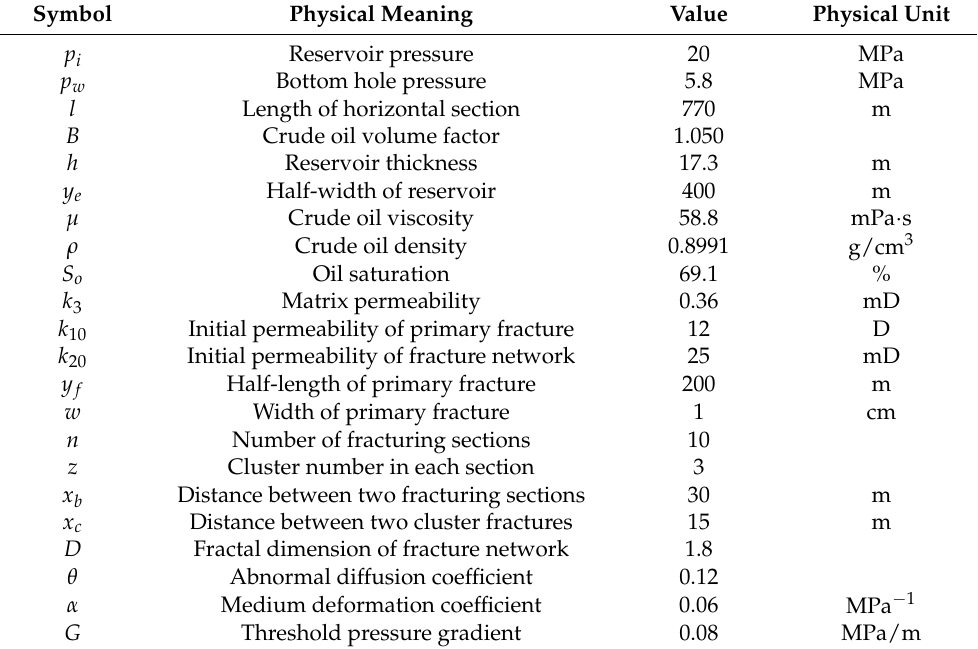
Table 2. Primary parameters of well B1 in block B.